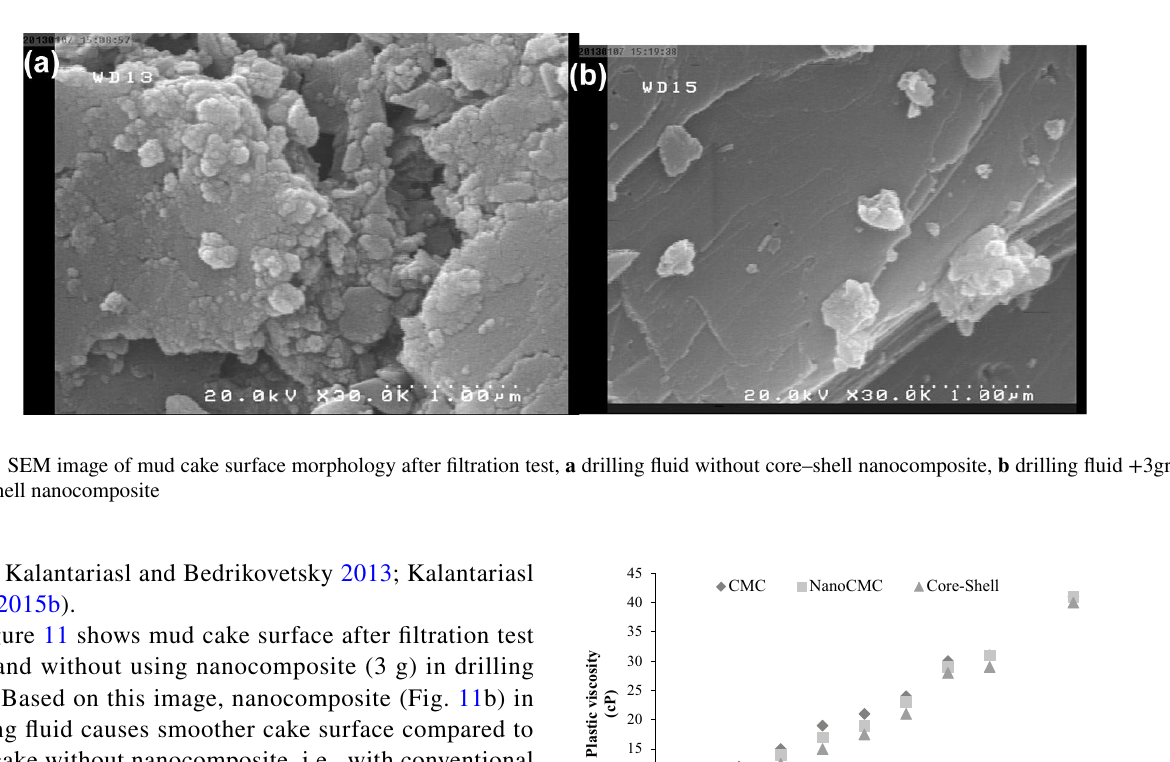
Fig. 10 Schematic: effect of particle size on fluid loss